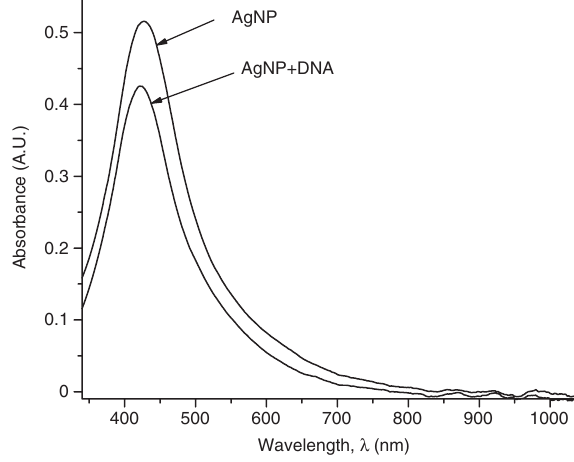
Figure 2 Absorption spectra of AgNPs and AgNPs-DNA complexes.